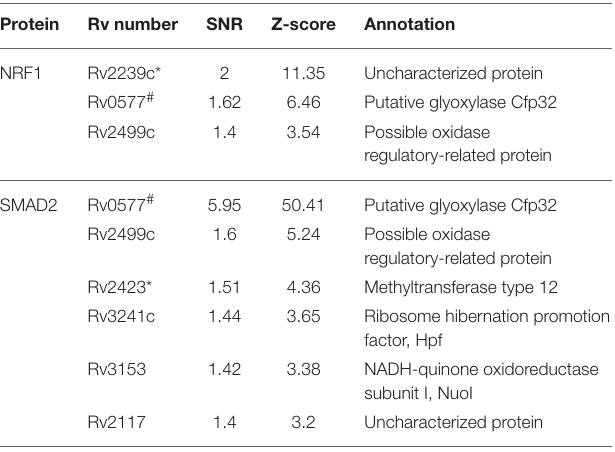
TABLE 2 | The list of NRF1 and SMAD2 interactors in Mtb identified on a Mtb proteome microarray.